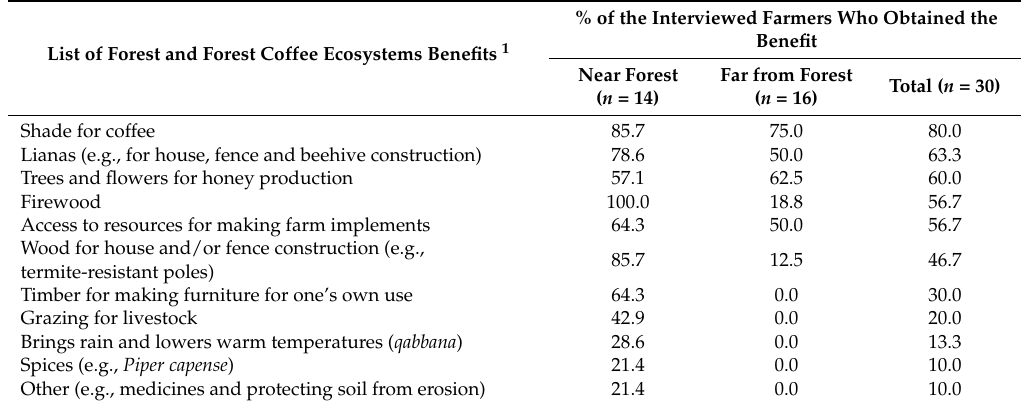
Table 2. Benefits the farmers interviewed in 2013 obtained from the forest and forest coffee ecosystems in the Gera district of